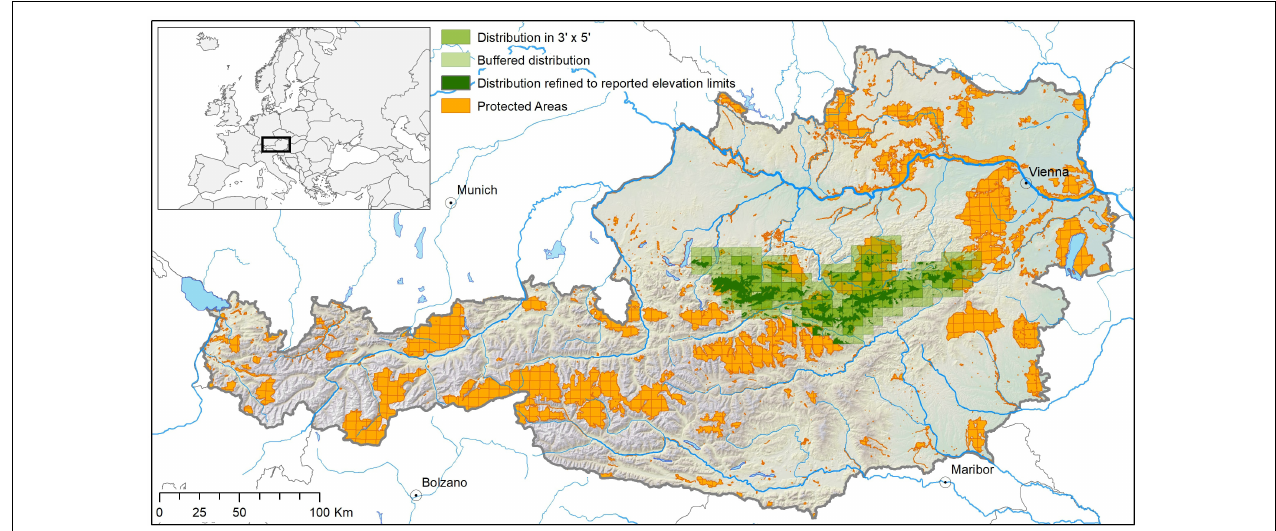
FIGURE 1 | Derivation of species distribution from 3 (cid:48) × 5 (cid:48) raster maps and information on elevational range limits illustrated for the vascular plant species Achillea clusiana . The light green area describes the range extent at the 3 (cid:48) × 5 (cid:48) raster-scale, and the dark-green area the assumed occupancy within this extent at the 1 ha scale. For more details see text. Country borders are adaped from GADM (https://gadm.org/); rivers are adaped from OSM